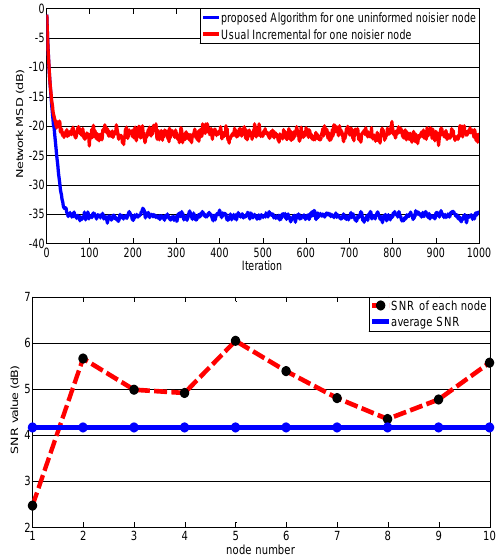
Figure 8. Transient network MSD for usual (red) and proposed (blue) incremental LMS for first uninformed noisier node (top) and new network design (bottom).